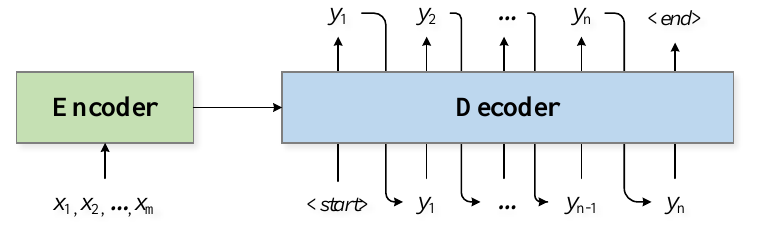
Figure 2. An encoder-decoder model autoregressively generates an output word sequence based on the input. < start > and < end > are the special tokens representing the generation’s start and